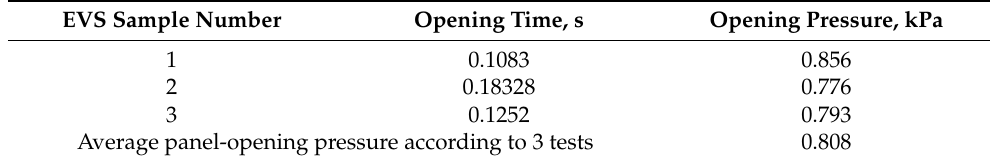
Table 1. Integral data obtained during EVS sample tests.